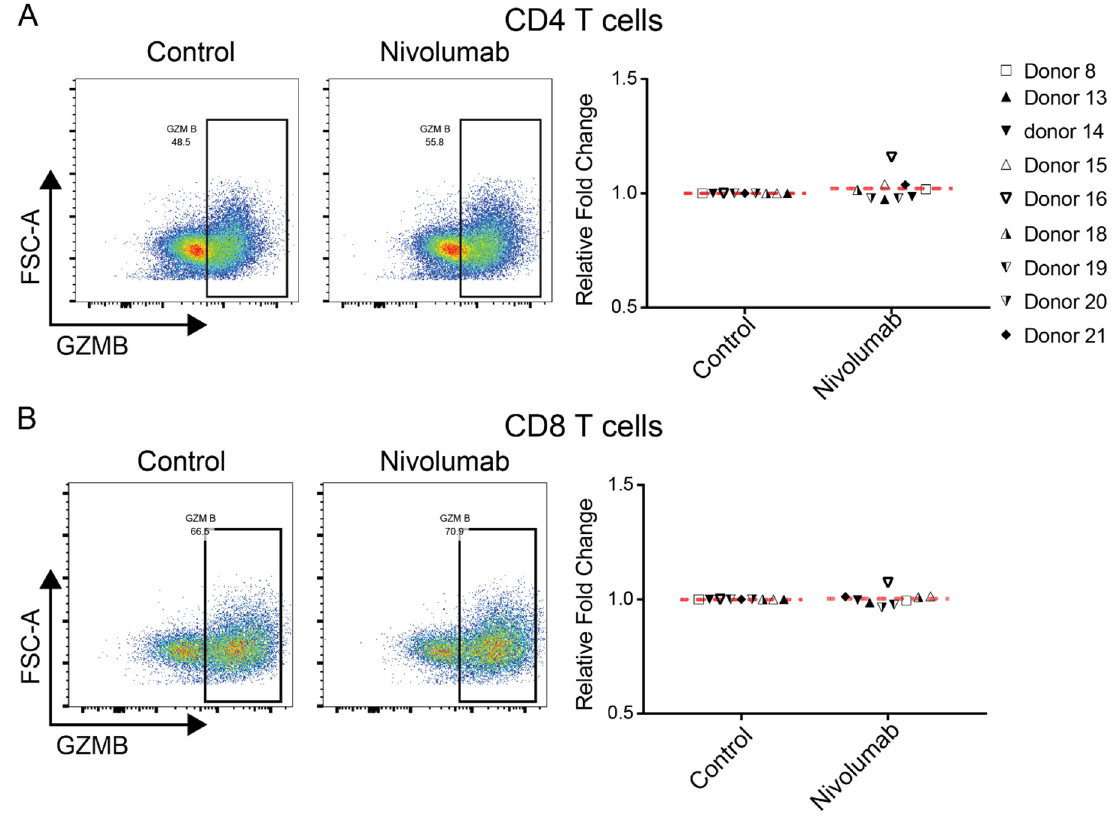
Figure 5. Nivolumab treatment does not impact the expression of Granzyme B. Frozen PBMCs were thawed and cultured in RPMI1640 medium containing 5% AB human serum. Cells were then treated with Nivolumab (20 μ g/mL) in the presence of anti-CD3 mAb (0.1 μ g/mL) for three days and were then harvested for flow cytometric analysis of expression of Granzyme B. Shown is the expression of Granzyme B in CD4 + T cells ( A ) and CD8 + T cells ( B ). The left panels depict data from one representative donor, whereas the right panel provides a summary of data from nine different individual donors.